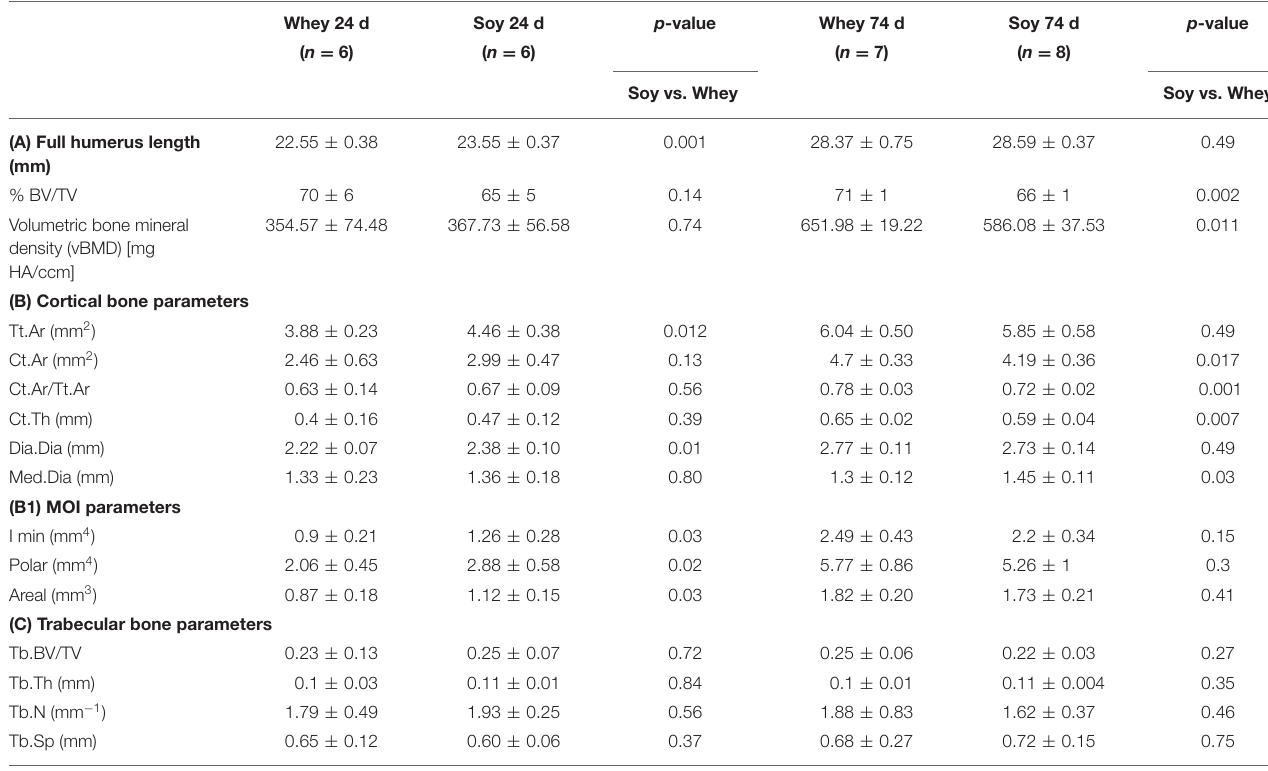
TABLE 3 | Bone parameters ( µ CT) in male Sprague-Dawley rats after 24 or 74